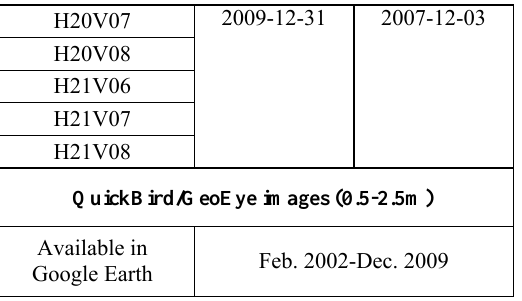
Table 1. Satellite dataset used in this study (Note: Landsat ETM+ and MODIS images were freely obtained from the USGS data server: http://glovis.usgs.gov/) As this method was applied manually, its main limitation was the difficulty to count all trees when the number was more than 40-50. Another shortcoming arising was that when the tree canopy size varied significantly inside the plot, we had to measure the crown diameter for all trees. The advantages of this approach were its simplicity and ease of use, especially, in case of crown shading due to the low Sun-Elevation angle and low heterogeneity among tree canopy sizes. One point should be clarified: the tree or shrub of which canopy diameter ( d i ) is < 2m was not